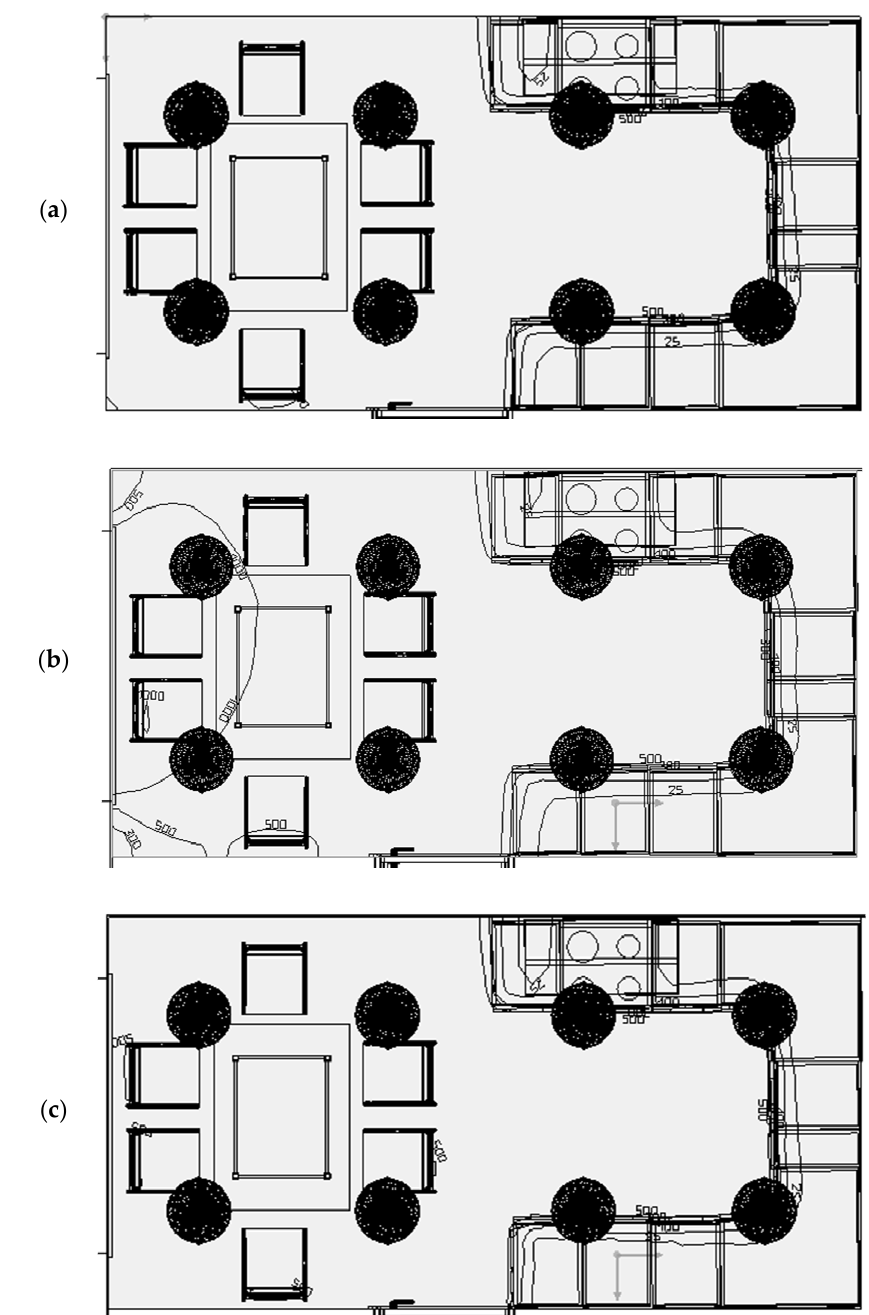
Figure A4. The even pattern of the simulation result from combining the artificial light of the smart adaptive lighting system for 750 lux illumination and the sunlight in DIALuxEvo 8.1 ( a ) at sub-scenario A, 6:00 a.m., 1 May 2019; ( b ) at sub-scenario B, 9:00 a.m., 5 June 2019; and ( c ) at sub-scenario C, 4:00 p.m., 10 November 2019.